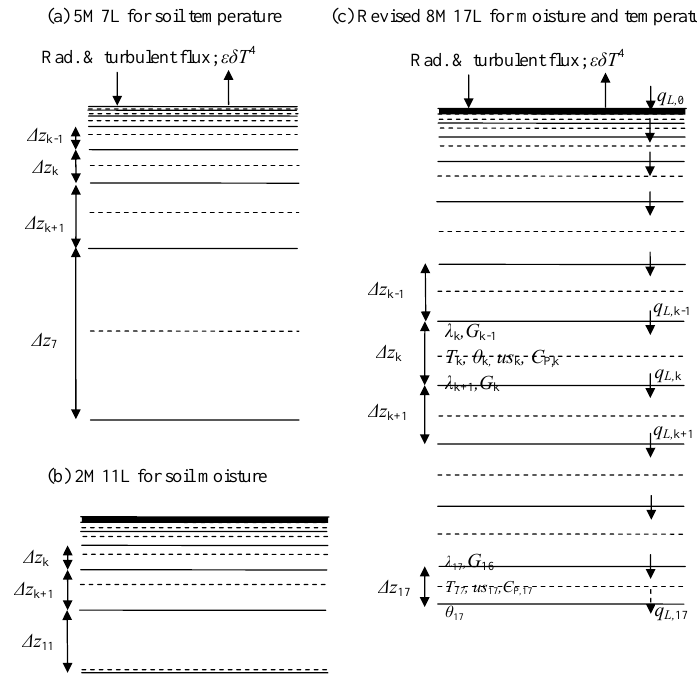
Figure 2. The soil vertical discretization of (a) 5M7L (Hourdin, 1992), (b) 2M11L (de Rosnay et al., 2000), and (c) 8M17L (new). The dashed and solid lines are the node and interface, respectively. For 2M11L, the top layer/bottom layer node and interface are at the same position. The heat transferred by liquid water at the bottom layer ( q L , 17 ) is zero. θ , volumetric soil moisture (m 3 m − 3 ); q L , liquid water flux (ms − 1 ), q L,k = − 0 . 5 × ( D(θ k − 1 ) + D(θ k ) ) × ( θ k - θ k − 1 )/(cid:49)z k + 0.5 × ( K(θ k − 1 ) + K(θ k ) ); D , hydraulic diffusivity (m 2 s − 1 ); K , hydraulic